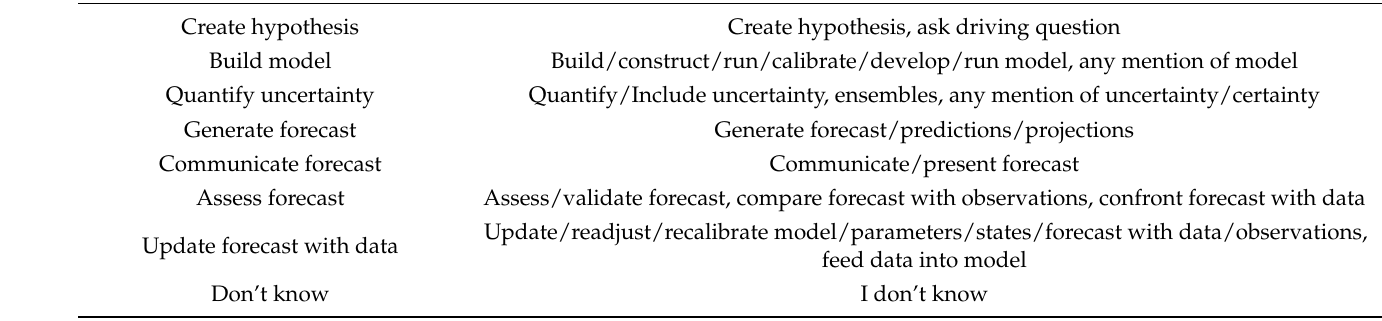
Table A5. Coding criteria used for the Q 5 thematic bins were developed using the two-step process described in